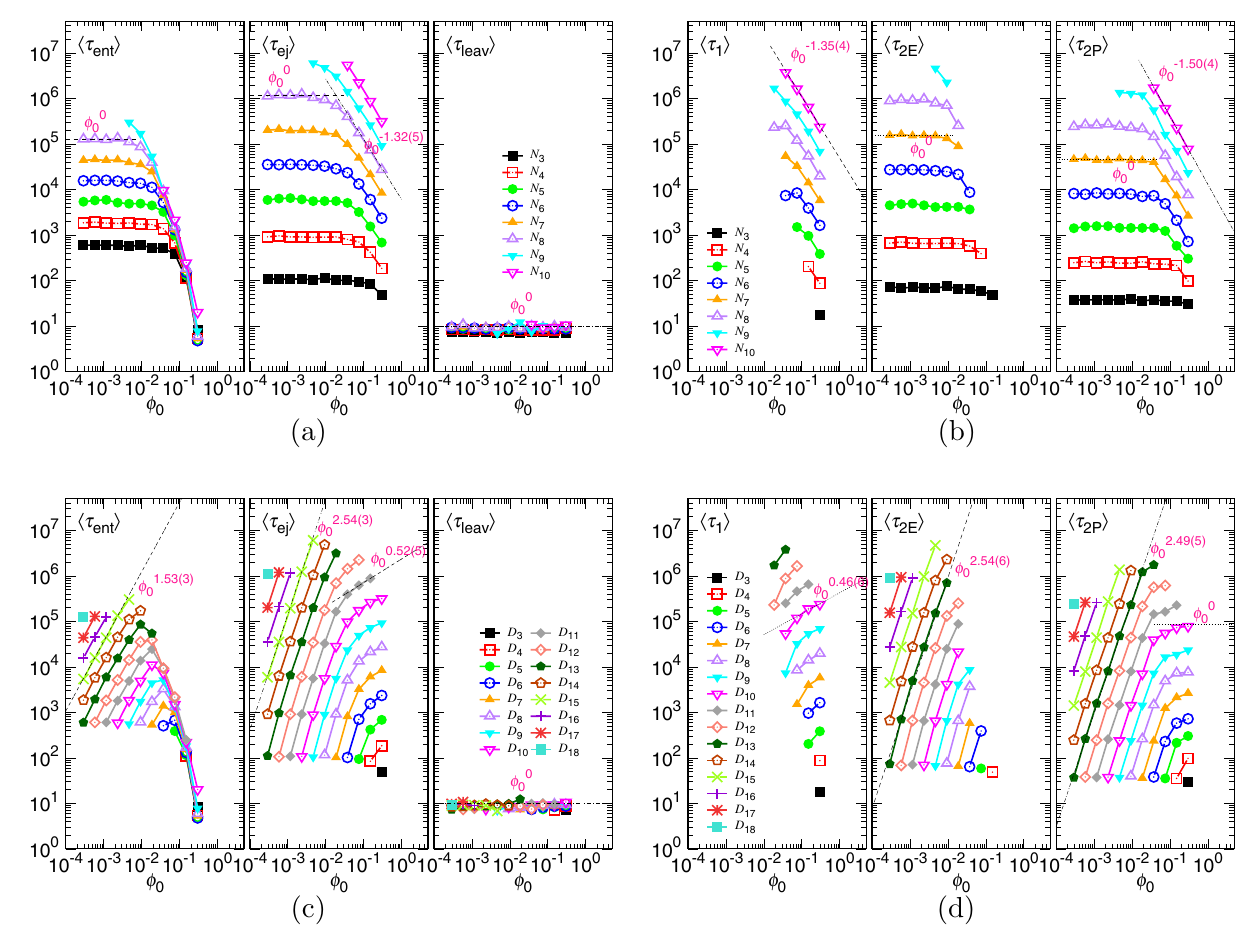
τ ej τ ent τ leav Figure 16. ( a ) , , , and ( b ) (cid:31) (cid:30) (cid:31) (cid:30) (cid:31) (cid:30) condition. The chain length N is indicated in the legends with N i τ 2E τ 2P , as a function of φ 0 , plotted under the D -fixed condition. The D value can be found in the legends, (cid:31) (cid:30) (cid:31) (cid:30) calculated by Eq. (7).